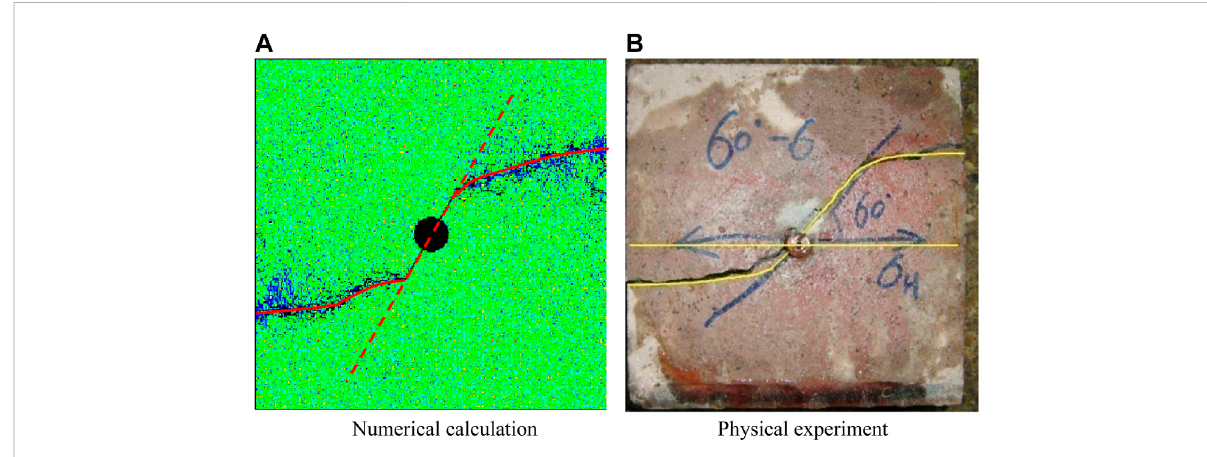
FIGURE 4 Comparison of the de fl ection trajectory of hydraulic fracture between numerical calculation and physical experiment.